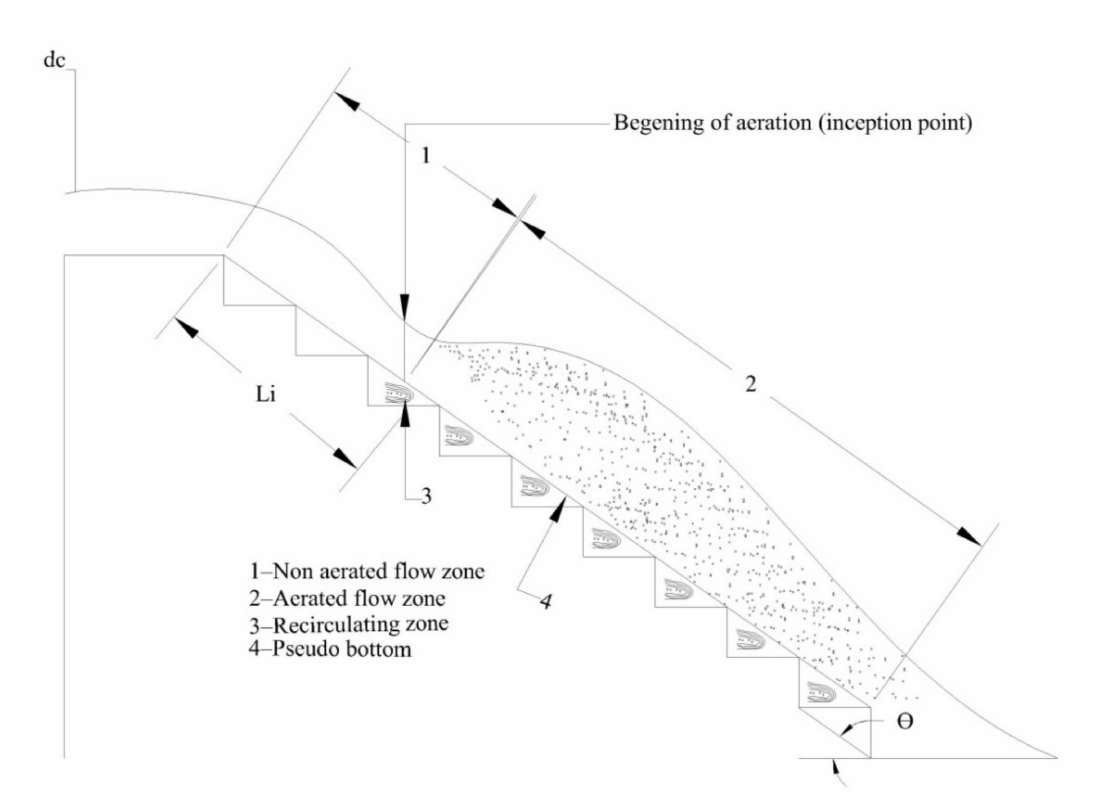
Figure 1. The geometry of a stepped spillway with air entrainment during the skimming flow regime.